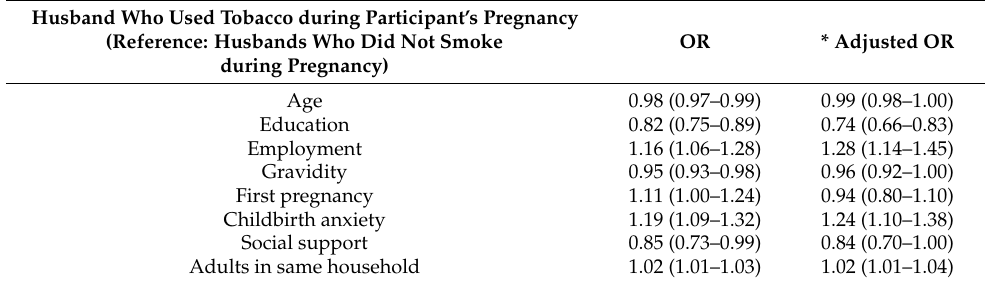
Table 3. Crude and multivariate regression model results on the associations between socio- demographic and pregnancy-related factors and self-reported husband tobacco use amongst pregnant women in Al Ain, UAE. The Mutaba’ah Study.